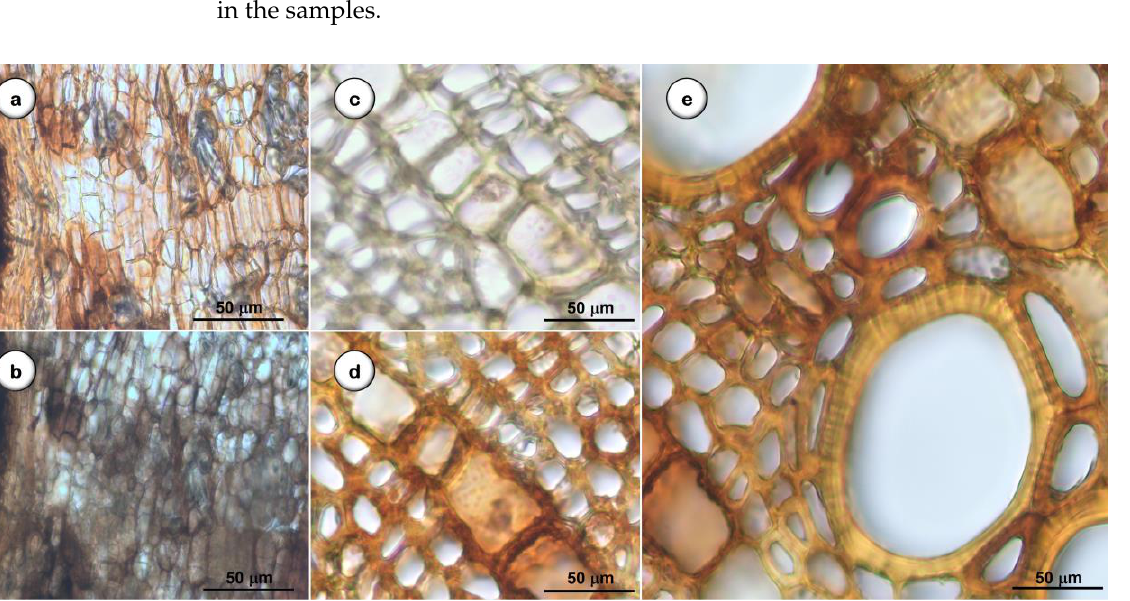
Figure 6. D. villosa root, histochemical characterization. ( a – c ) before, ( b ) quinones, and ( d , e ) tannins. Bars = 50 µm. Bars = 50 µ m. Table 3. D. villosa root – histochemical screening results. Table 3. D. villosa root–histochemical screening